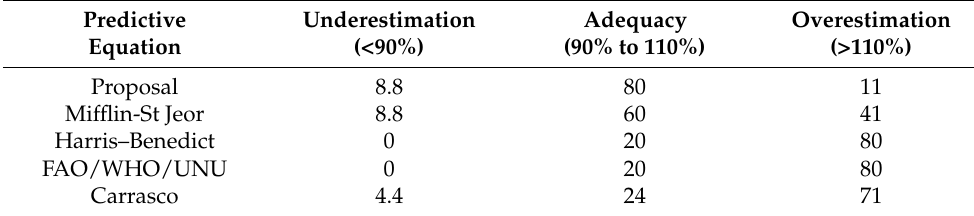
Table 3. Percent adequacy (overestimation/underestimation) of predictive equations as related to resting metabolic rate measured by indirect calorimetry in the studied sample.